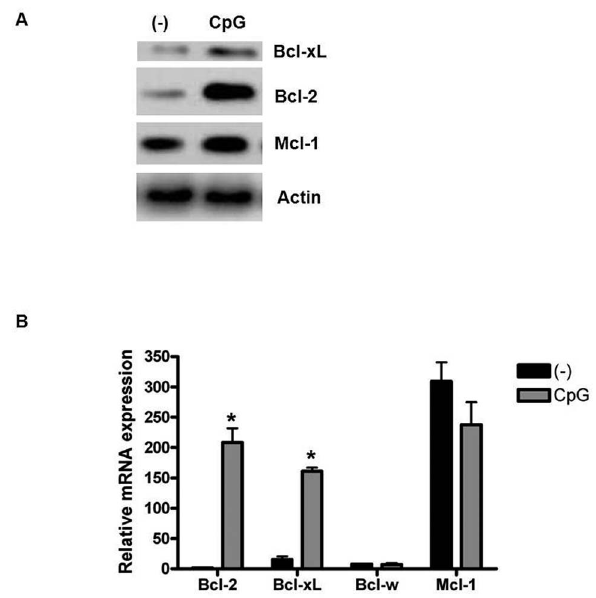
Figure 3. Changes in Bcl-2 family member expression in human primary pDCs following CpG stimulation. Western blot (A) and qRT-PCR (B) analyses of Bcl-xL, Mcl-1, and Bcl-2 expression after 12 hours of stimulation with CpG. The data are representative of at least 3 independent experiments, each using a different pDC preparation. Data are expressed as the mean 6 SD and were analyzed with a 2-tailed Student’s t test. *P , 0.05.